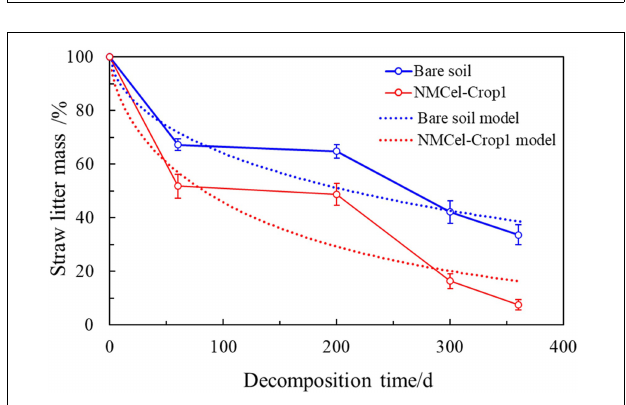
FIGURE 6 | Straw decomposition rate accelerated by the NMCel-crop1 fungus in the field experiment.